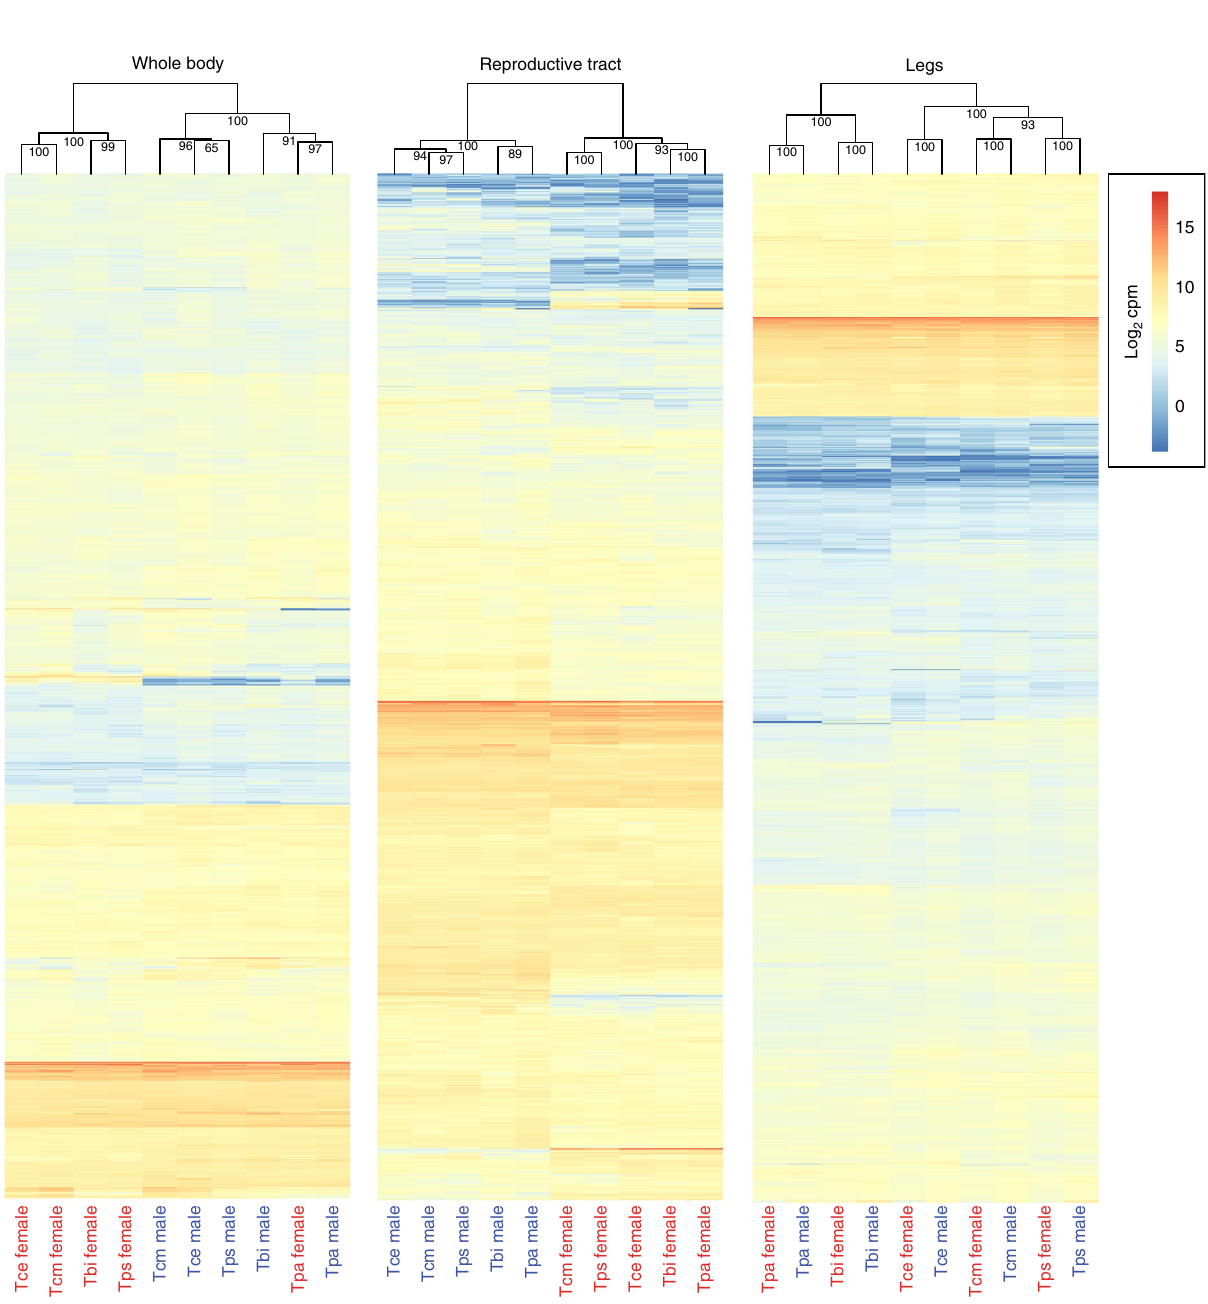
Fig. 4 Heatmaps and hierarchical clustering of gene expression. Gene expression (log 2 CPM) for whole-body, reproductive tract and leg samples are plotted separately. Values on each node show the bootstrap support from 10,000 replicates. Species names are abbreviated as follows: Tbi = T. bartmani , Tce = T. cristinae , Tps = T. poppensis , Tcm = T. californicum , Tpa = T. podura . Source data are provided as a Source Data fi